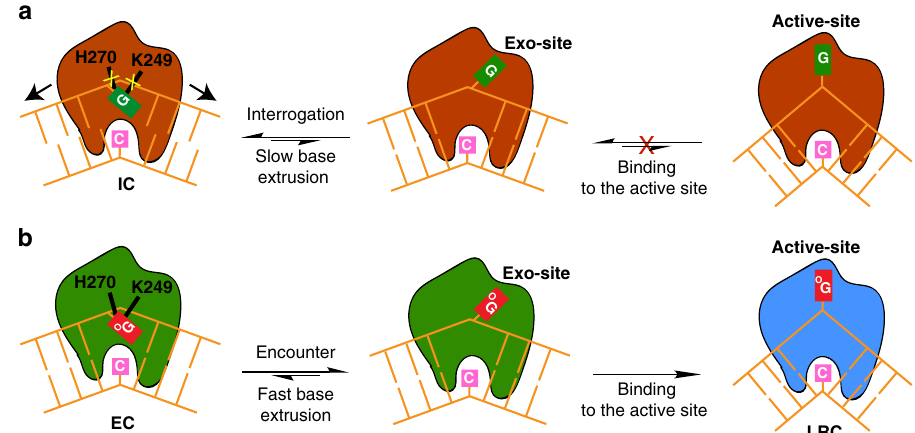
Fig. 6 Discrimination of oxoG ( O G) versus G. a H270 and K249 do not engage with G in IC, thus there is no or slow base extrusion, while the enzyme fl uctuates back-and-forth along the target DNA strand. b H270 and K249 speci fi cally recognize oxoG and facilitate the extrusion of oxoG. It then enters the active site of the enzyme to initiate its catalytic